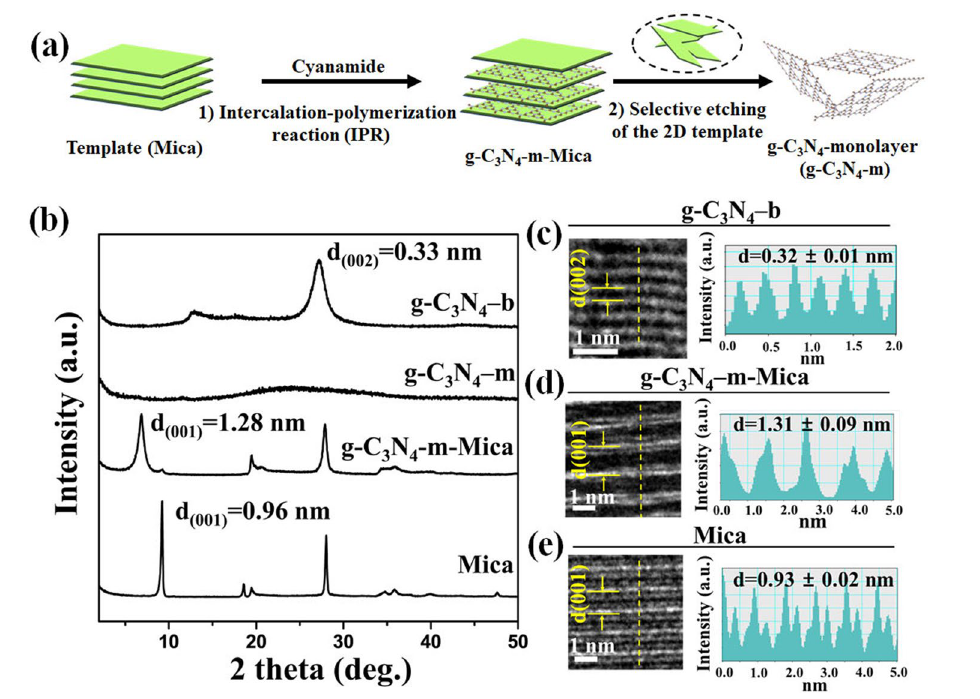
Fig. 1 a Schematic diagram for the synthesis of g‑C 3 N 4 –m by using the 2D Mica template. b XRD patterns of Mica, g‑C 3 N 4 –m–Mica, g‑C 3 N 4 – m and g‑C 3 N 4 –b. c–e Cross‑sectional HRTEM images and photometric intensity profiles along the yellow dashed lines for g‑C 3 N 4 –b, g‑C 3 N 4 – m–Mica and